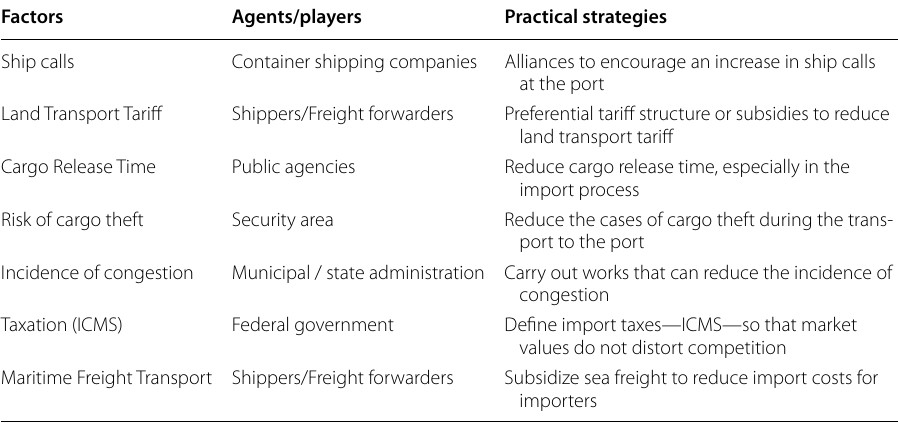
Table 7 Practical strategies for the identified